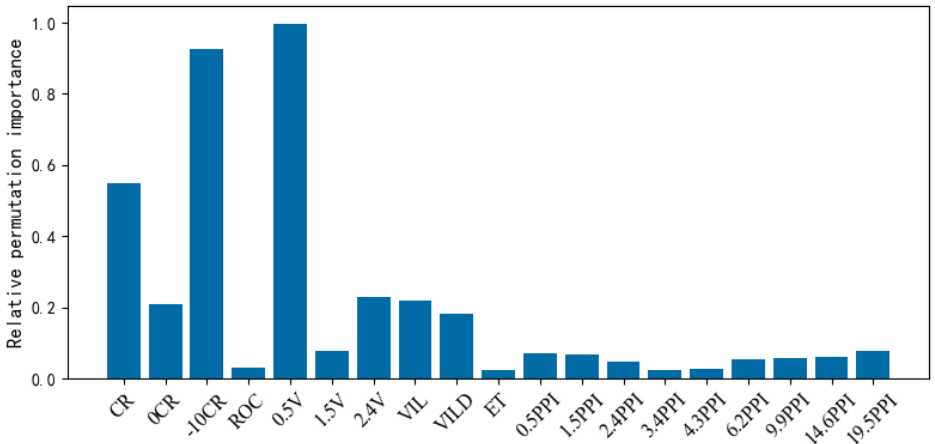
Figure 5. Relative permutation importance of each characteristic factor in the Lightning-SN model. CR (composite reflectivity), ROC (recognition of clouds), V (velocity), VIL (vertically integrated liq- uid), VILD (vertically integrated liquid density), ET (echo-top height), PPI (echo of the plane-posi- tion indicator).